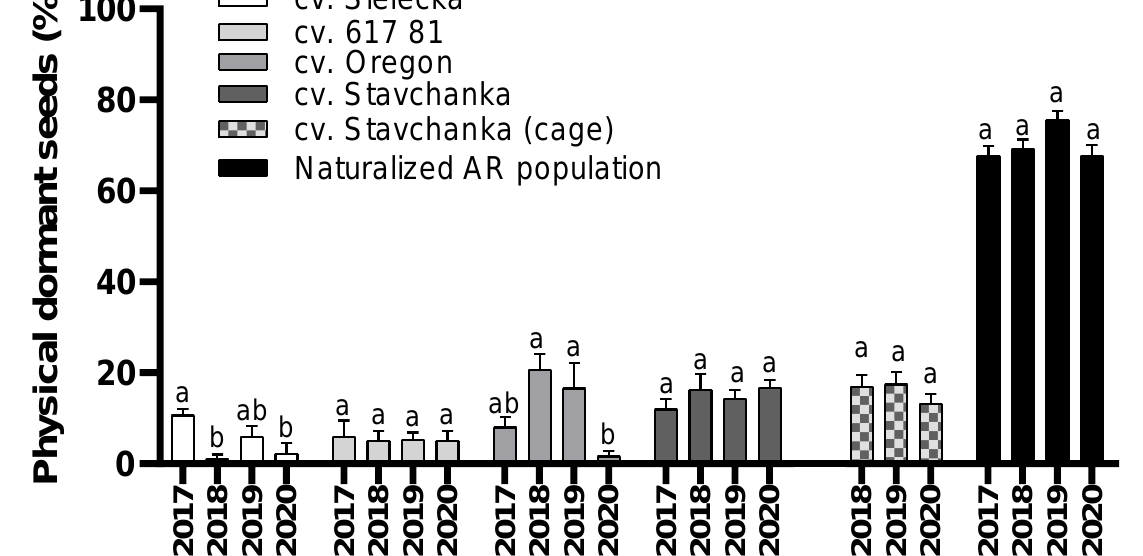
Figure 1. Percentage of seeds with physical dormancy (PY) for each genotype (mean and standard error) evaluated in a common garden during 2017–2020 with the first generation (G 0 ) from EU produced freely and Stavchanka in exclusion cages with honey bees (cage). Different letters indicate significant differences between years for each genotype (Fisher’s LSD test, α = 0.05).